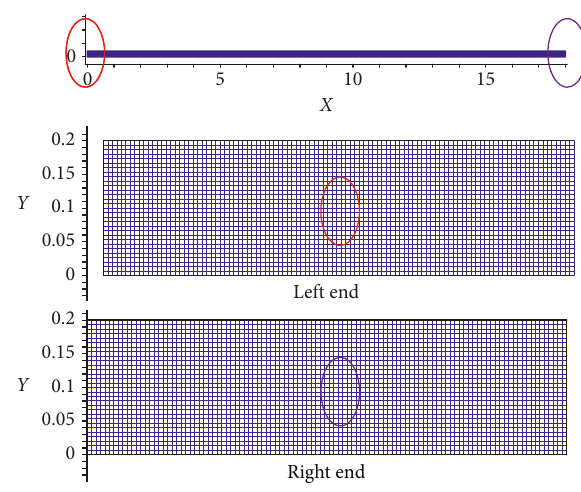
Figure 2: Grid layout of deflagration for the